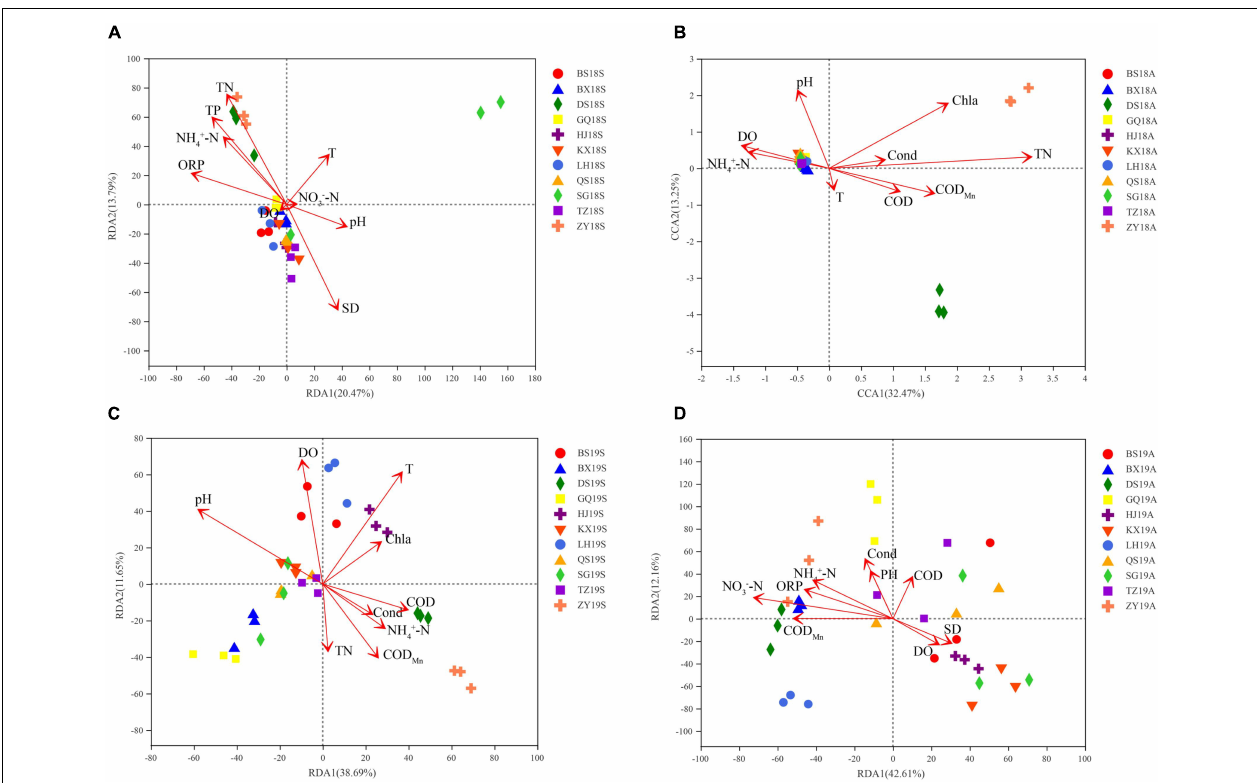
FIGURE 4 | RDA, CCA of 2018S (A) , 2018A (B) , 2019S (C) , 2019A (D) bacterioplankton communities of and physico-chemical water quality